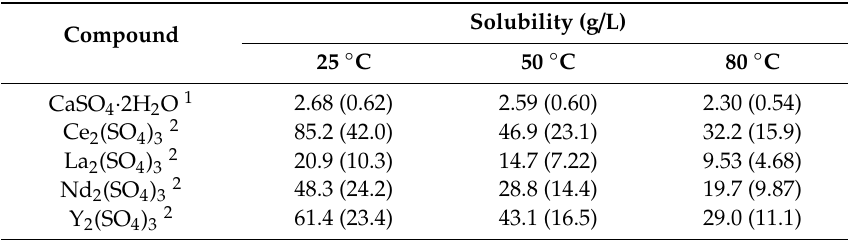
Table 4. Solubilities of Ca sulfate and REE sulfate compounds at 25, 50 and 80 ◦ C (the numbers inside the parentheses are the solubility of Ca and REEs).